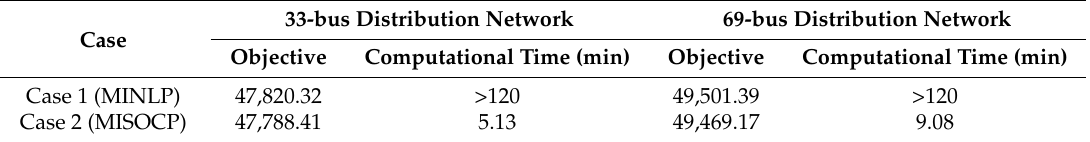
Table 6. Optimal results of the two methods.